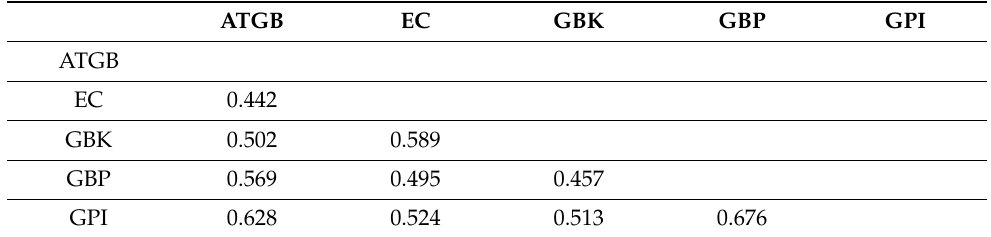
Table 4. Discriminant validity